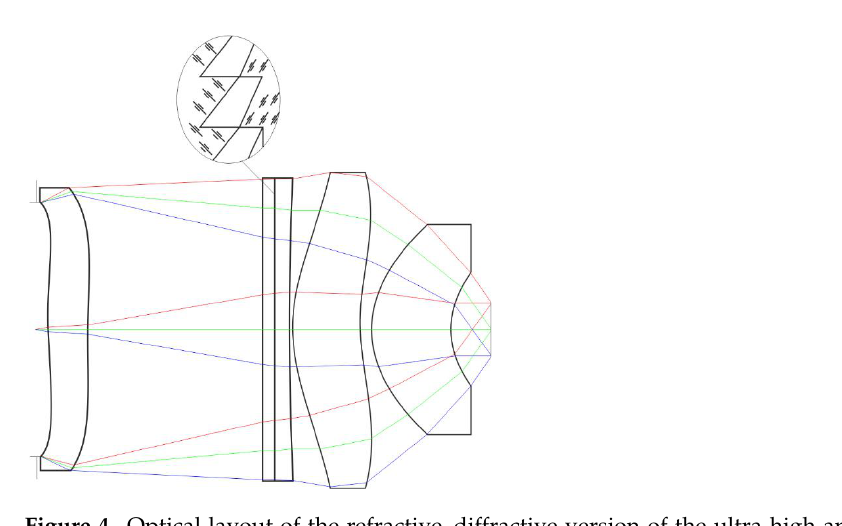
Figure 3. Optical layout of the refractive version of the ultra-high-aperture athermal dual-range IR objective.